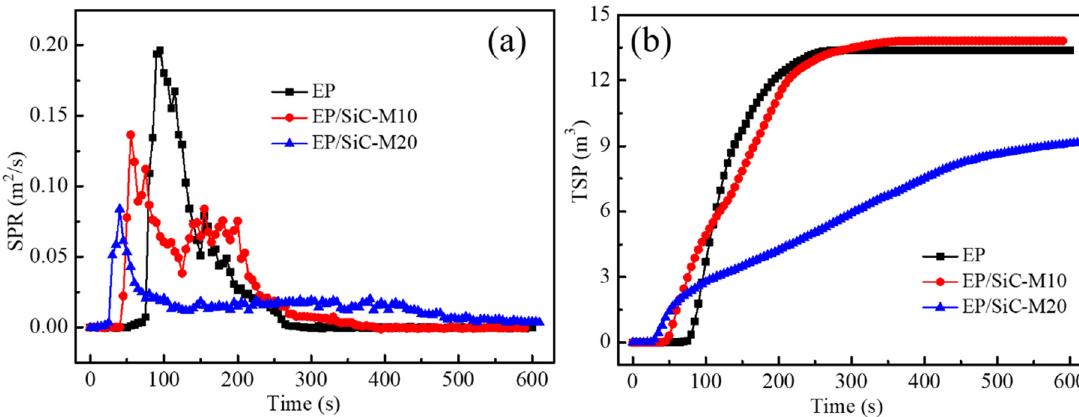
Figure 7: Smoke production rate ( a ) and total smoke production ( b ) versus time curves of EP and composites EP/SiC - M.